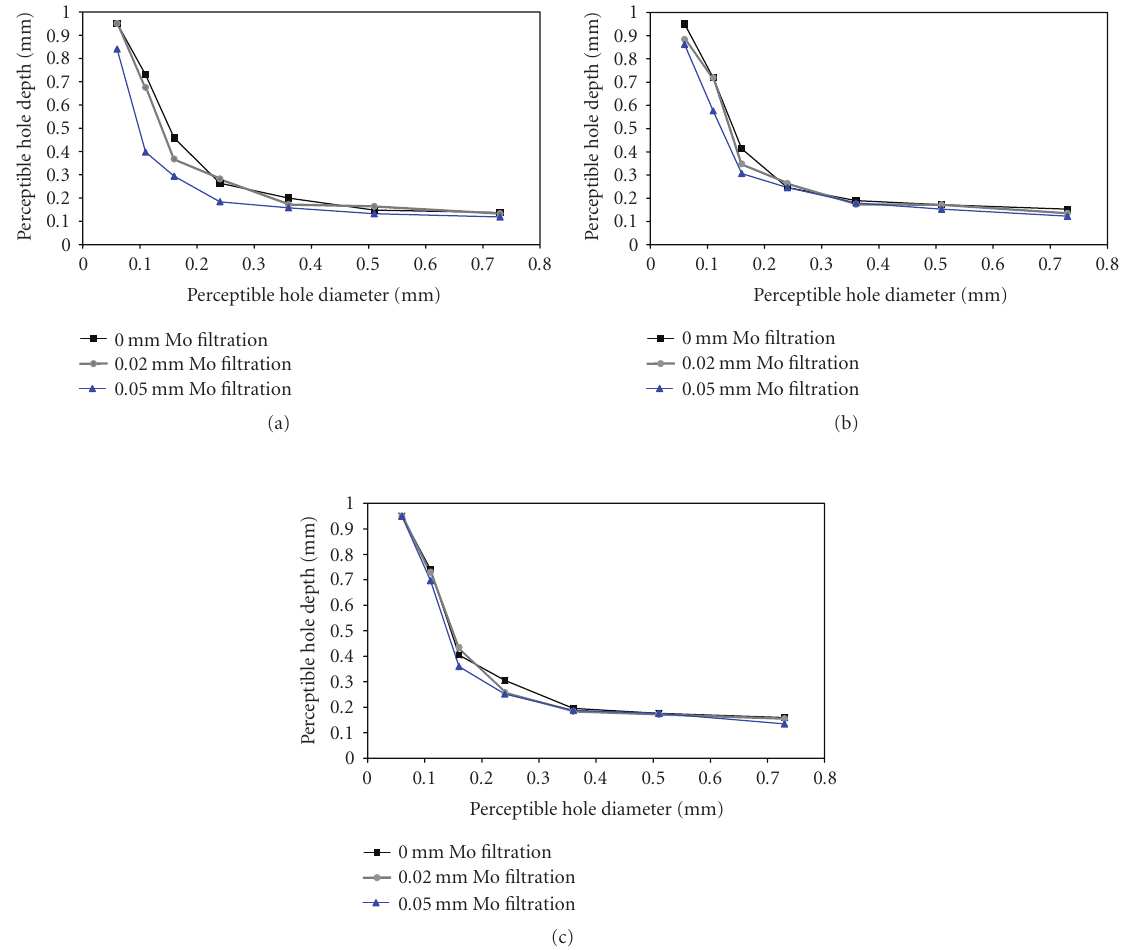
Figure 5: (a) Contrast-detail curves using the 1 . 15 cm phantom under the exposure of 22 kVp with a 0 . 0cm (curve with squares), 0 . 02 cm (curve with circles), and 0 . 05 cm (curve with triangles) Mo filter. (b) Contrast-detail curves using the 1 . 15 cm phantom under the exposure of 28 kVp with a 0 . 0cm (curve with squares), 0 . 02 cm (curve with circles), and 0 . 05 cm (curve with triangles) Mo filter. (c) Contrast-detail curves using the 1 . 15cm phantom under the exposure of 35kVp with a 0 . 0 cm (curve with squares), 0 . 02cm (curve with circles) and 0 . 05 cm (curve with triangles) Mo